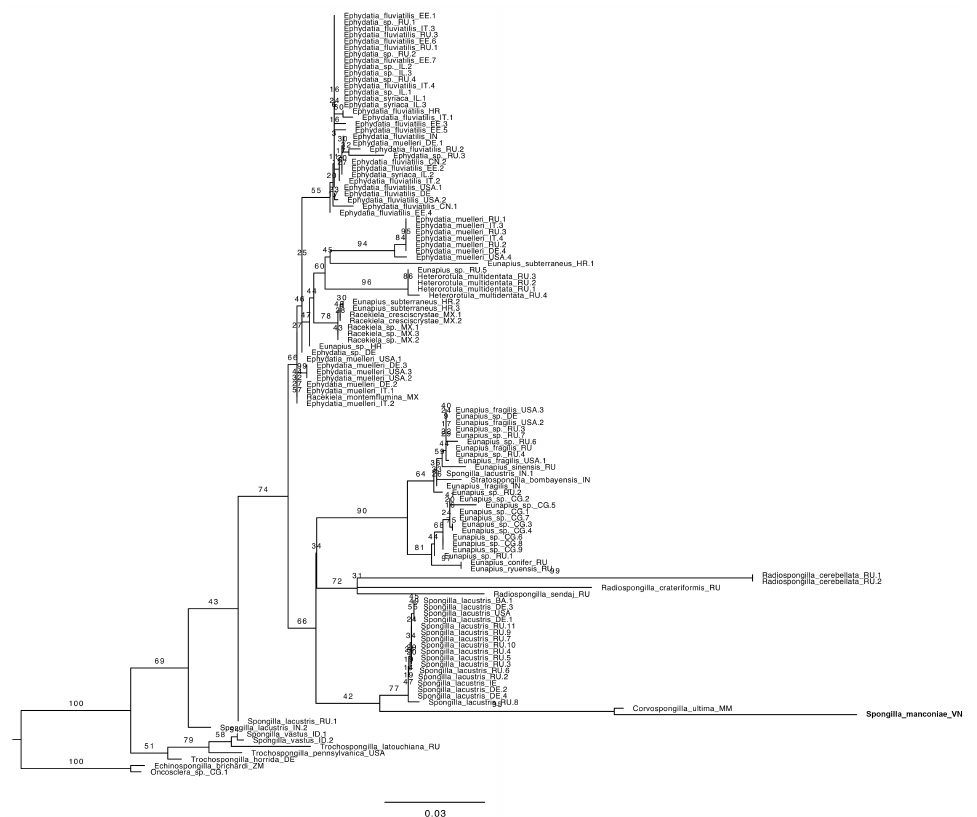
Figure 6. Maximum likelihood phylogenetic tree applying the concatenated data set of COI and curated ITSs, with the bootstrap values shown at each node. The analysis was built with the newly described sponge, Spongilla manconiae sp. nov., along with a representative suite of reference sequences in the Spongillidae Family plus two outgroup entries ( Echinospongilla bichardi and Oncosclera sp.) downloaded from the GenBank database. The country codes and Accession numbers can be found in Supplementary Table S1. Table S1: Reference sequences downloaded from GenBank database for COI marker gene of sponge species in the Family Spongillidae, plus Echinospongilla .